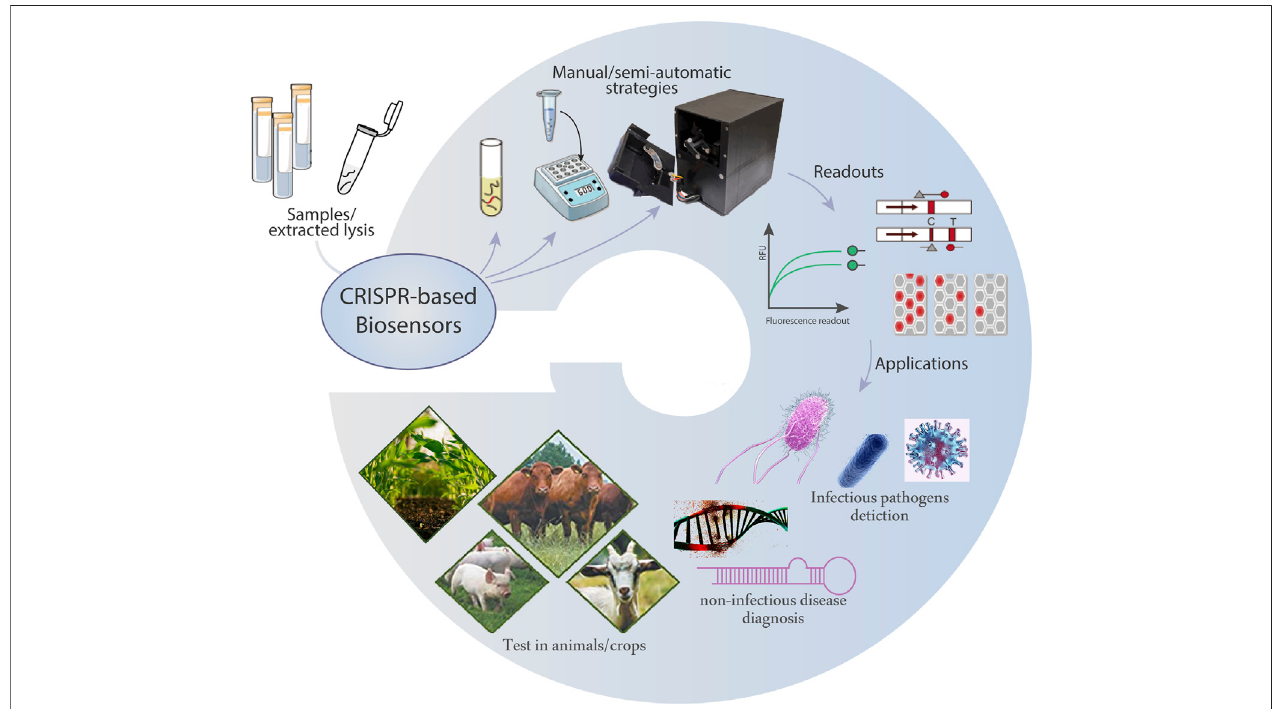
FIGURE 2 | Illustration of the wide applications of CRISPR-based